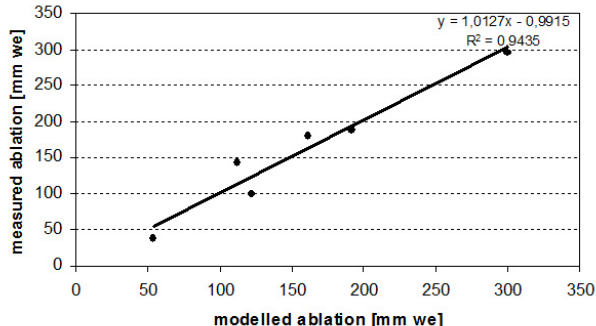
Fig. 3. Comparison between measured and modelled ablation at Martial Este Glacier for the period 21 December 2005 until 22 February